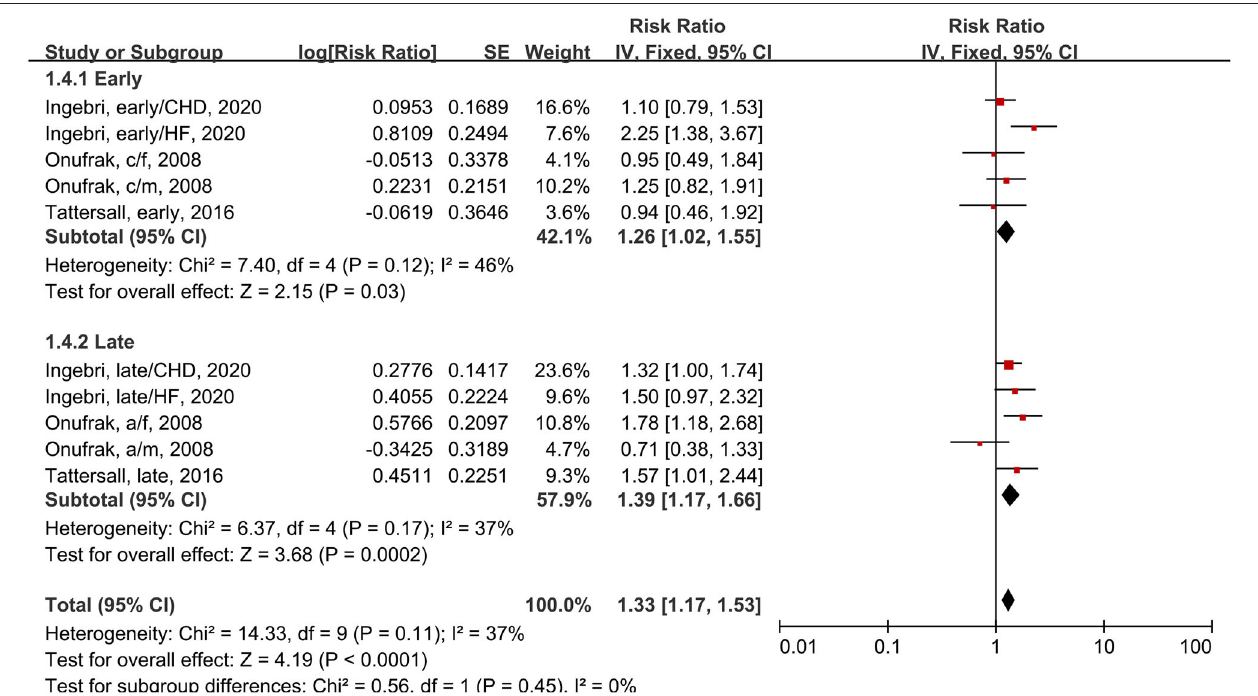
FIGURE 5 | Forest plot shows association between asthma and CVD morbidity in early and late-onset asthma patients. SE, standard error; IV, Inverse Variance method; df, degrees of freedom; HF, heart failure; CHD, coronary heart disease; a/f, adult female; a/m, adult male; c/f, child female; c/m, child